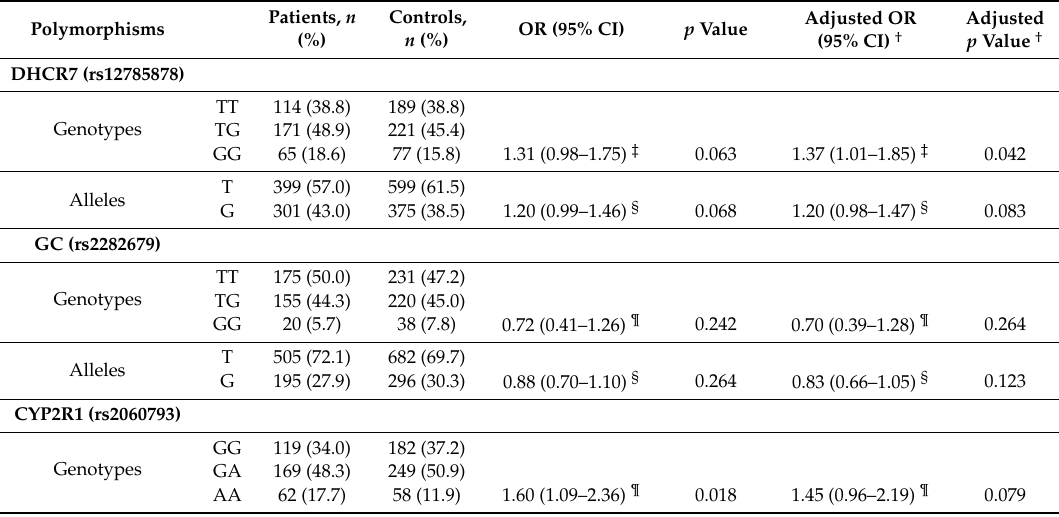
Table 1. Distribution of DHCR7 , GC , CYP2R1 and CYP24A1 genotypes and alleles in type 1 diabetes and